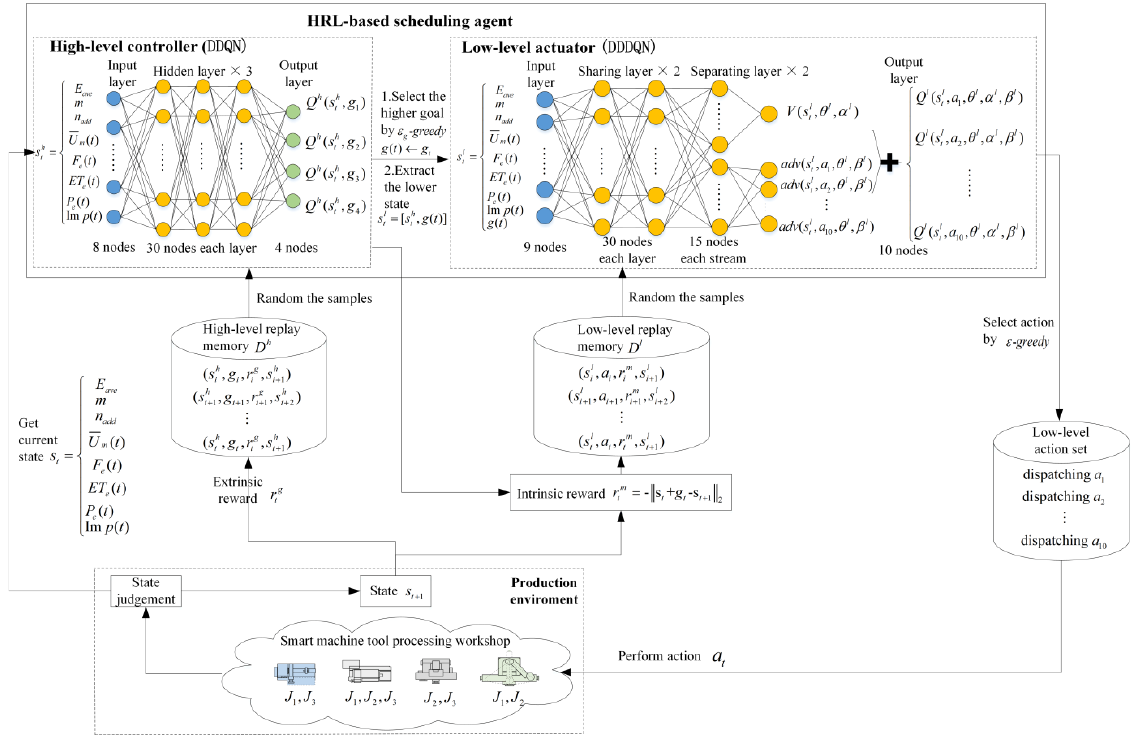
Figure 2. The model architecture of HRL used for solving the MODFJSP.